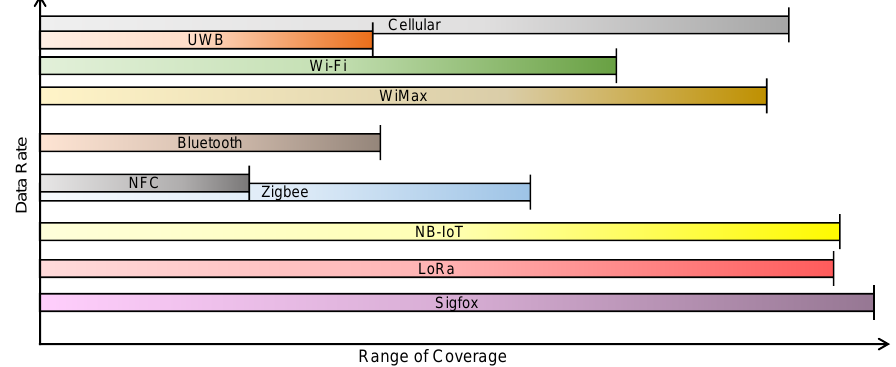
Figure 8. Comparison of various wireless communication technologies.